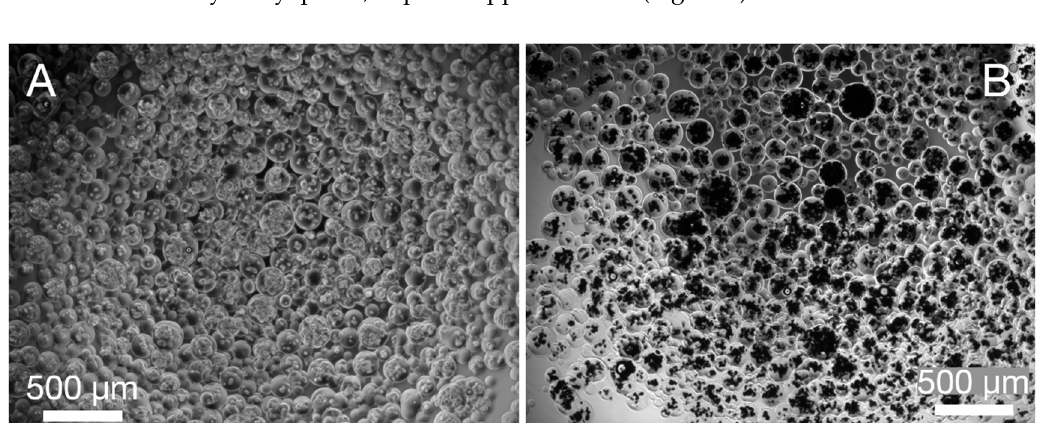
Figure 1. Phase contrast images hTERT-hMSCs at different time points following microencapsulation. Cells were imaged 24 h ( A ) and 3 weeks ( B ) after encapsulation using phase contrast microscopy. Cells appear bright and hydroxyapatite mineral deposits appear dark.